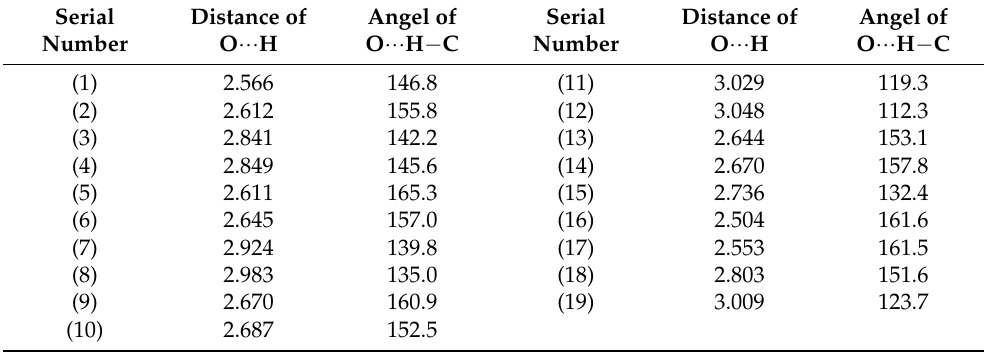
Figure 1. Optimized geometries of CO 2 coordination on six Ru–PNP complexes with different substituents. Pink balls: Ru; orange: P; red: O; blue: N; cyan: C; white: H; The distances are in Å, and the O − C − O bond angles are in degree ( ◦ ). The red dotted lines represent hydrogen bonds, and the number indicates the distance of O ··· H (Å). The detailed parameters of these hydrogen bonds are listed in Table 3. Table 3. Parameters of hydrogen bonds in the optimized geometries of CO 2 coordination on Ru–PNP